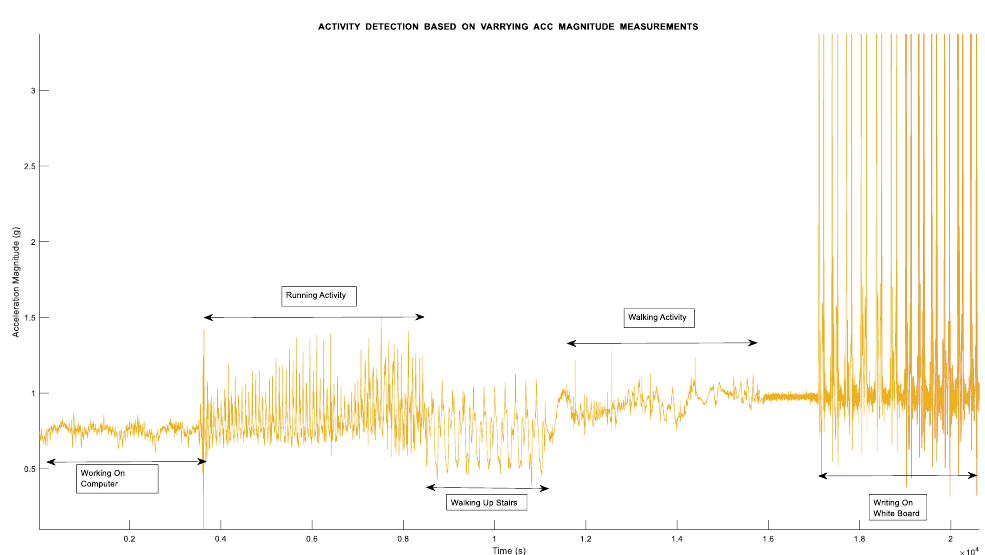
Figure 6. Activity detection using measurements of accelerometer sensor data.